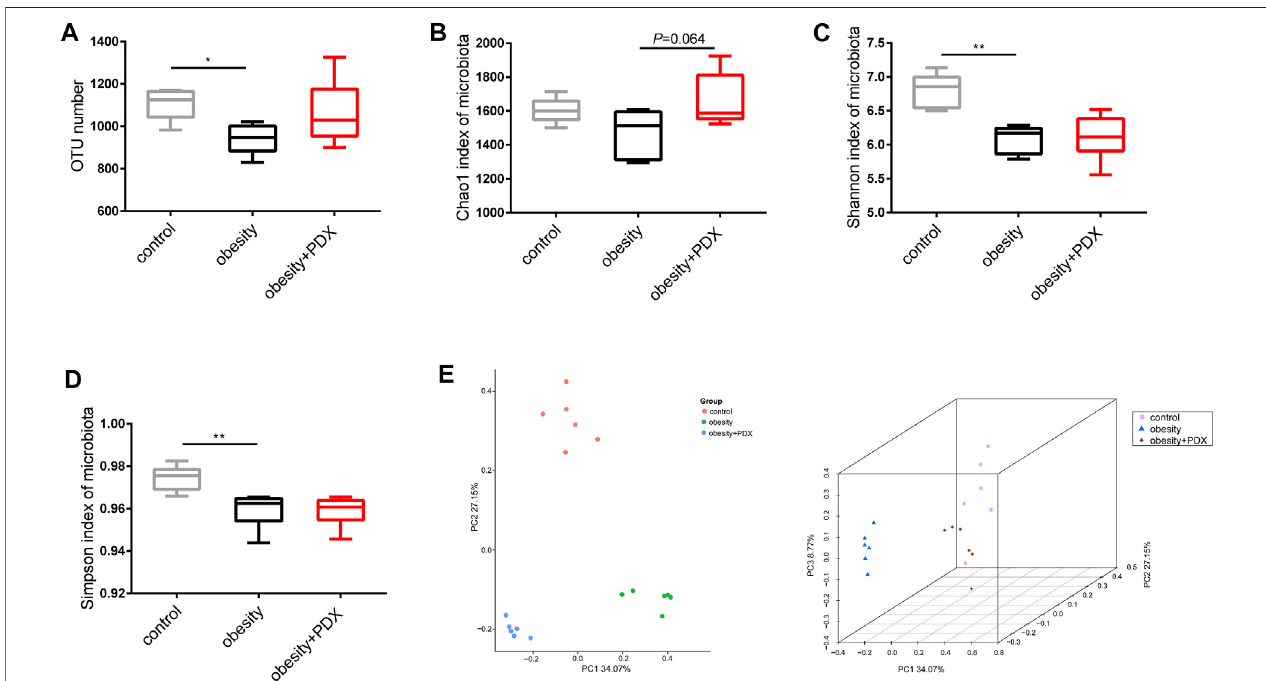
FIGURE 8| Alpha and beta diversity analysis ofgut microbiota in HFD-induced obese mice (Part 2). (A) OTU number. (B) Chao1 index of microbiota. (C) Shannon index of microbiota. (D) Simpson index of microbiota. (E) 2D and 3D PCoA plot (Bray-Curtis index) of microbial community structure in obese mice. OTU, operational taxonomic unit; PCoA, principal coordinate analysis. n (cid:2) 6 per group. * p < 0.05; ** p <